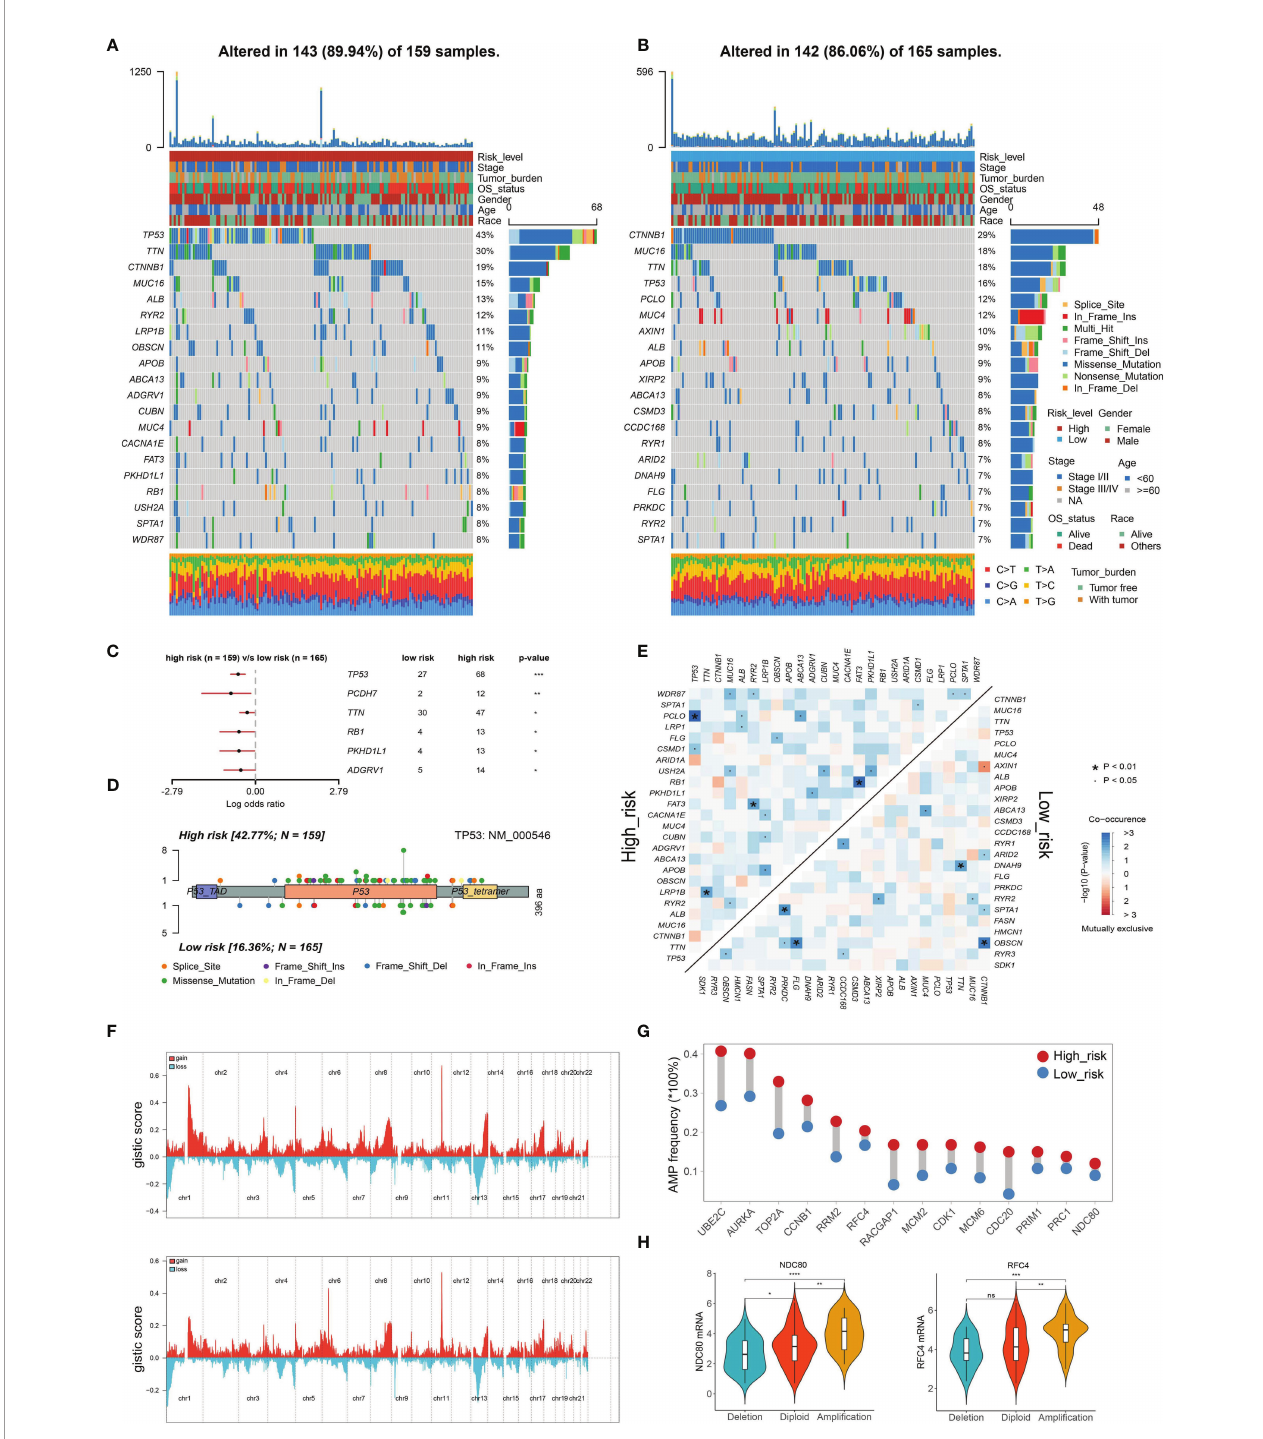
FIGURE 6 | Genetic alterations of the TIPRGPI low- and high-risk groups. (A, B) Waterfall plots displaying the mutation landscapes of the high- (A) and low-risk groups (B) . (C) Forest plot showing the signi fi cantly different mutated genes between the TIPRGPI risk groups. (D) Lollipop plot indicating the distribution of mutation spots in the high- and low-risk groups. (E) The coincident and exclusive associations across the top mutated genes in high- and low-risk groups. (F) The distribution of CNV features across all chromosomes for the high- (upper) and low- (bottom) risk groups. (G) HCC hub genes were widely ampli fi ed in the high-risk group. (H) Violin plots indicating the positive correlation of gene expression and copy number of two represented hub genes (NDC80 and RFC4) in the high-risk group. *P < 0.05, **P < 0.01, ***P < 0.001, ****P < 0.0001, ns, not signi fi